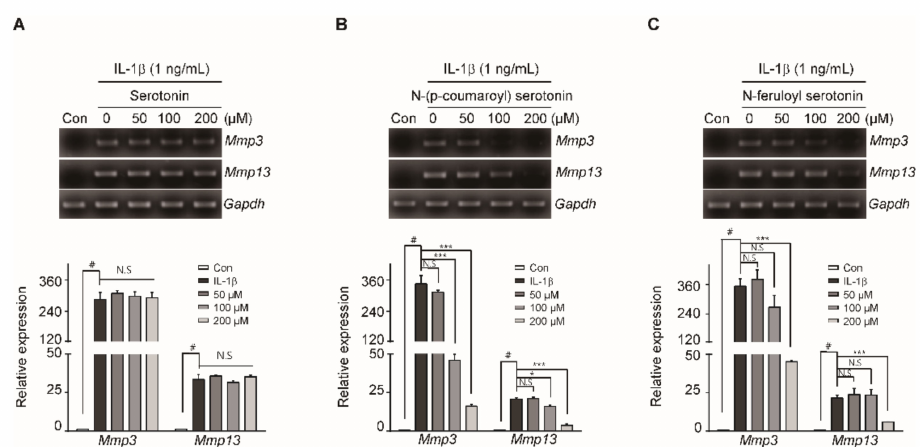
Figure 5. N-(p-coumaroyl) serotonin and N-feruloyl serotonin, but not serotonin, decreased the expression of MMP3 and MMP13 induced by IL-1 β in articular chondrocytes. Chondrocytes were treated with various concentrations (0, 50, 100, and 200 µ M) of serotonin, N-(p-coumaroyl) serotonin, and N-feruloyl serotonin ( B ). The mRNA expression levels of Mmp3 and Mmp13 were measured by RT-PCR ( A , B , C ; upper panel) and qRT-PCR ( A , B , C ; lower panel). Gapdh was used as the loading control. Data are presented as mean ± SD of each group ( n = 5). # p < 0.05 compared with the control; * p < 0.05, *** p < 0.001 compared with the IL-1 β -, serotonin-, N-(p-coumaroyl) serotonin-, and N-feruloyl serotonin-treated groups